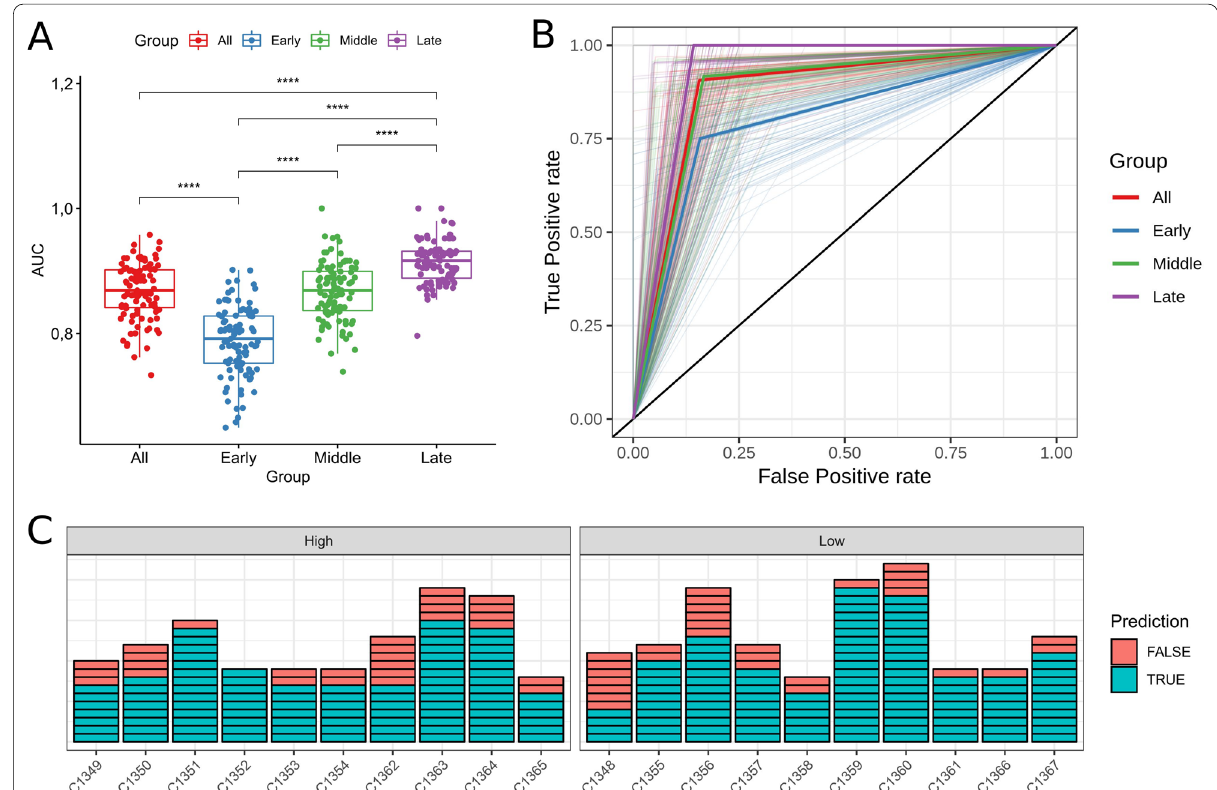
Fig. 6 Accuracy of the samples classification into shedding groups. A and B show classification for samples from the different life periods: “Early”— younger than 12 month, “Middle” — from 12 to 24 month, “Late”—older than 24 months, and “All”—samples randomly drawn from all age groups. A Box-plot of AUC per life period group—every dot represents AUC obtained in a single permutation; **** level of significance corresponds to p < 0.0001. B ROC curves plot—thin half-transparent lines represent ROC curves of individual permutations and thick solid lines are median ROC curves per group. C shows the number of miss-classified samples per animal when all samples from the corresponding animal removed from the RF model training dataset and used as the validation; samples are faceted by shedding